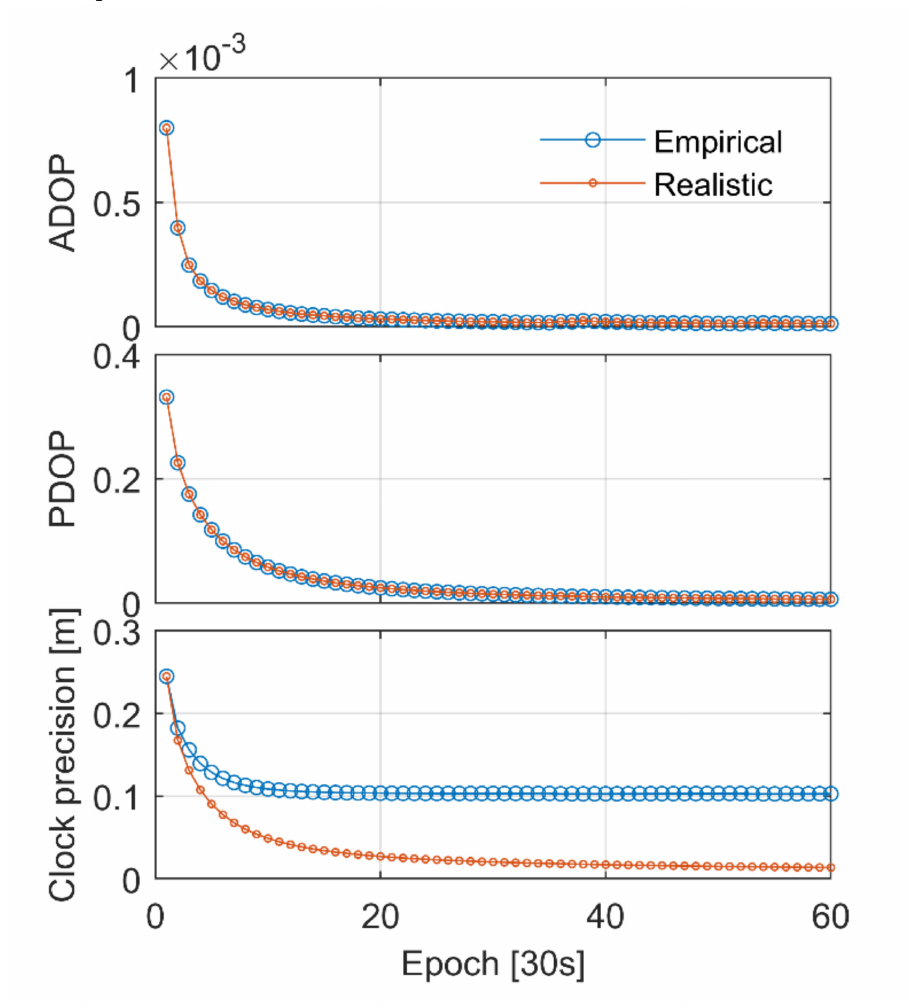
Figure 11. ADOP, PDOP, and clock precision in GPS+BDS+Galileo dual-frequency ionosphere-fixed RTK positioning with a realistic and an empirical stochastic model of RCB process noise. The empirical stochastic model refers to the one that sets the STD of RCB process noise as 10 m. The data were collected from baseline IGG1–IGG2 on DOY 270,